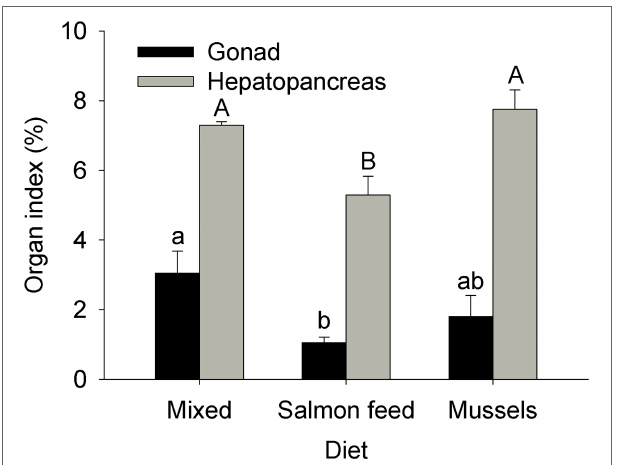
FIGURE 7 | Impact of experimental diets on carapace hardness measured at three positions on rock crabs Cancer irroratus . Replicates are the mean values for each experimental tank. Bars show mean +SE and columns not sharing a common letter are significantly different, ns = not significant (Tukey HSD post-hoc tests, n = 5-9). The total number of individuals included in the analyses was 23, 11, and 13 for the mixed, salmonid feed and mussel diets,